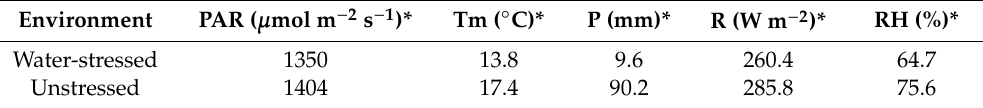
Table 1. Climate data recorded at the two sampling days. Daily mean photosynthetically active radiation (PAR), daily mean temperature (Tm), precipitation accumulated during the three weeks prior to the sampling date (P), daily mean solar irradiance (R), and daily mean relative humidity